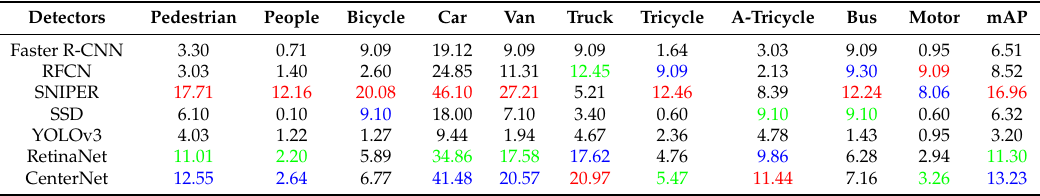
Table 5. The AP (IoU = 0.75) scores on the VisDrone2019 Validation set of each object category. The top three results are highlighted in red, blue and green fonts.